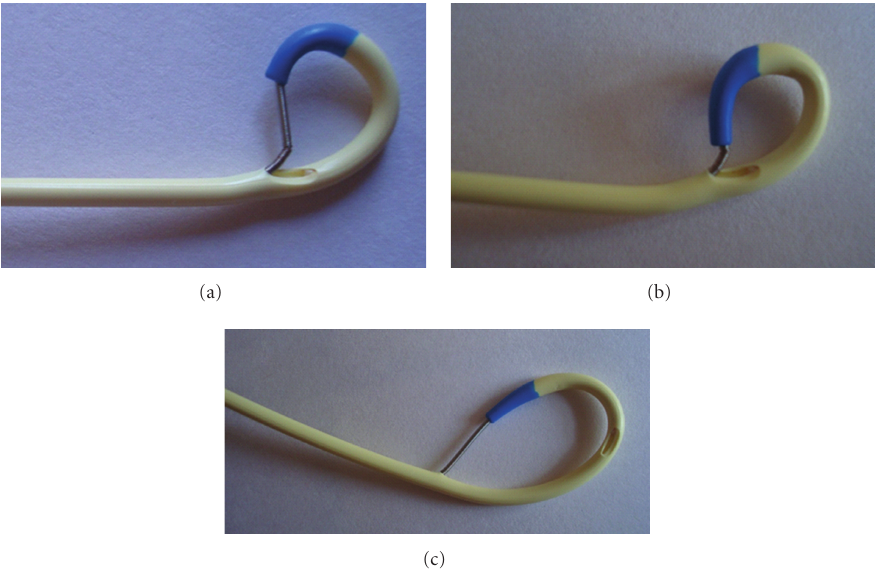
Figure 3: The possible mechanism of central venous catheter shear by the